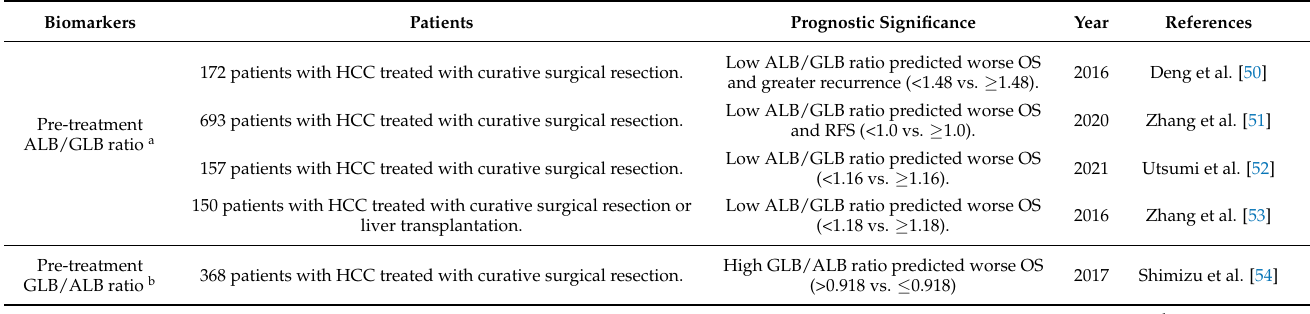
Table 4. Prognostic significance of serum ALB/GLB ratio in HCC